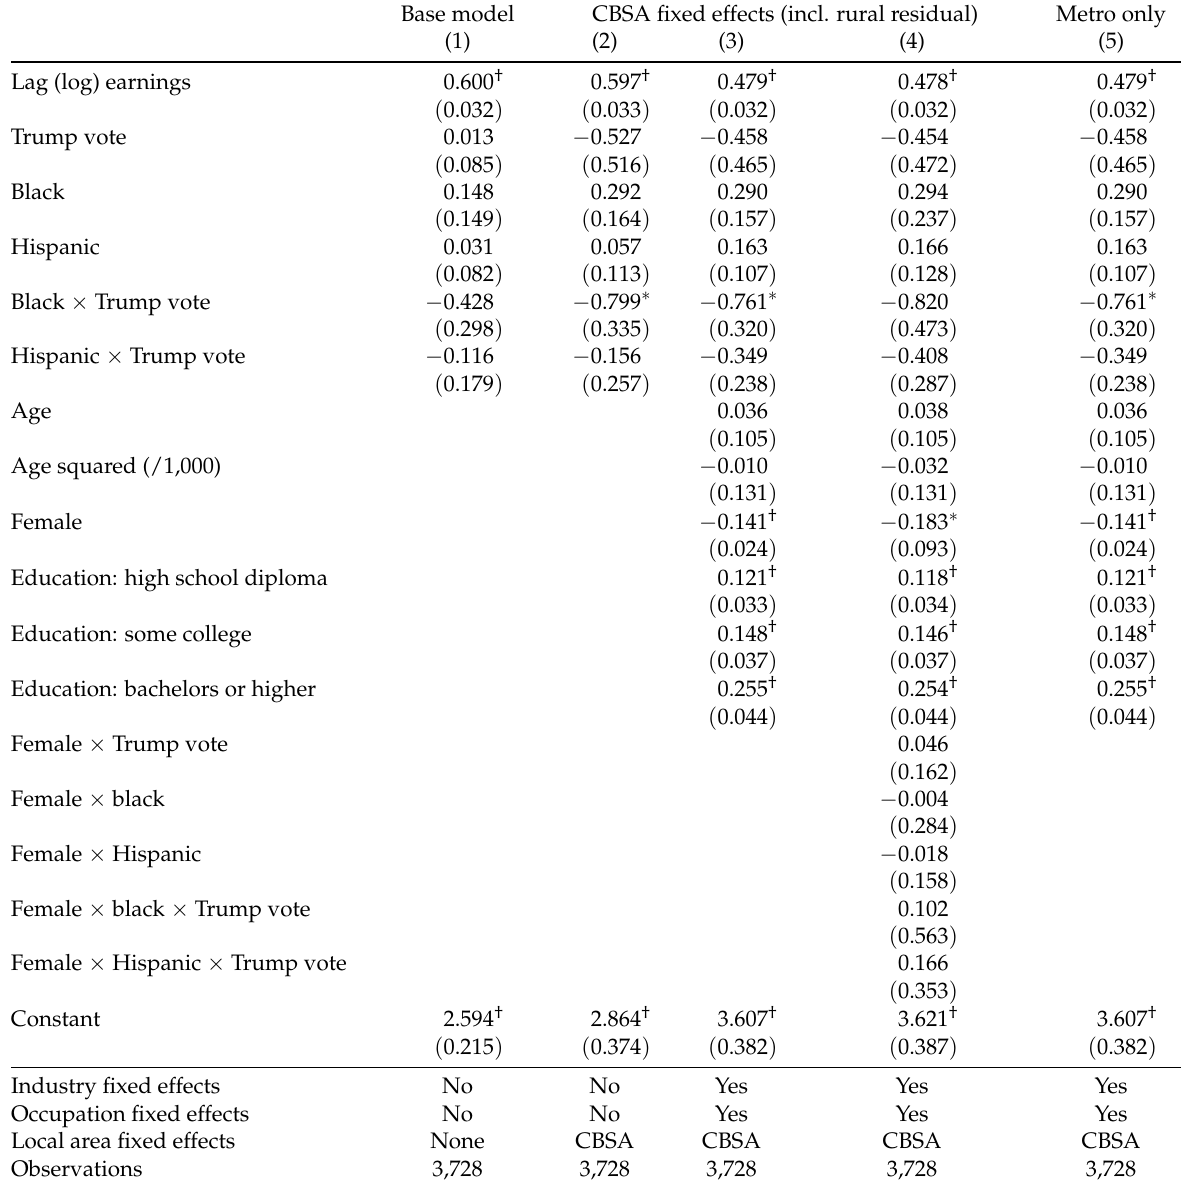
Table 3: Earnings: estimates from two-period lagged dependent variable models of weekly (log) earnings among hourly workers Base